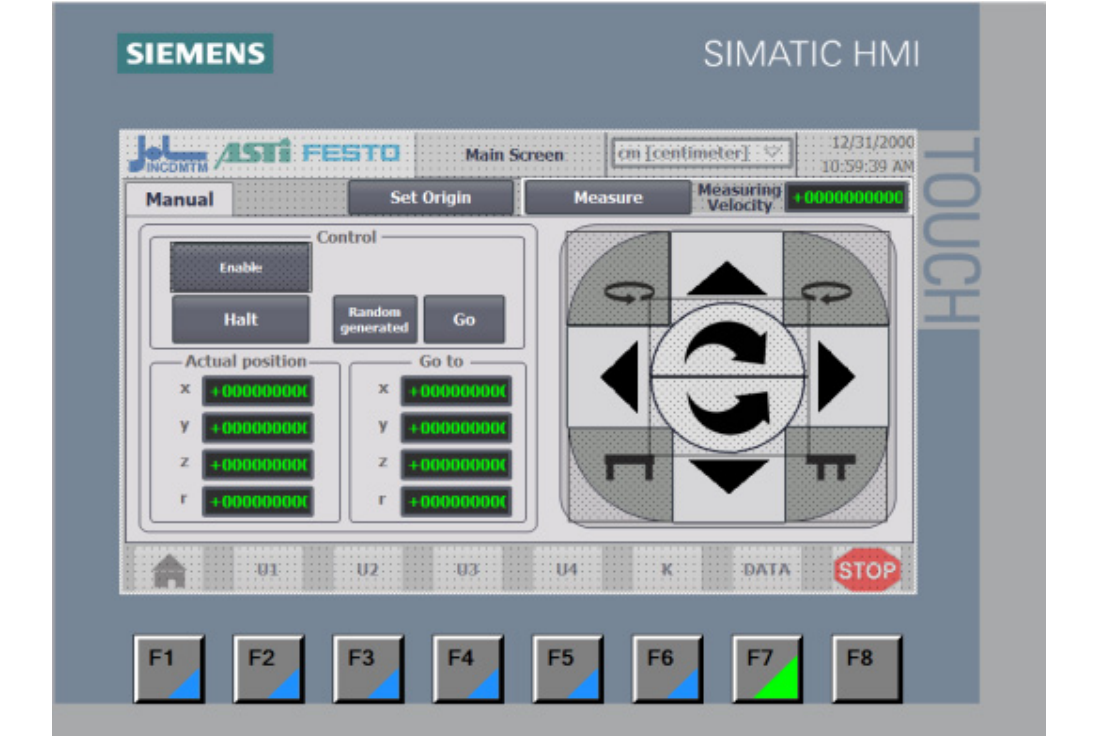
Figure 9. Simatic WINCC V14- HMI programming.